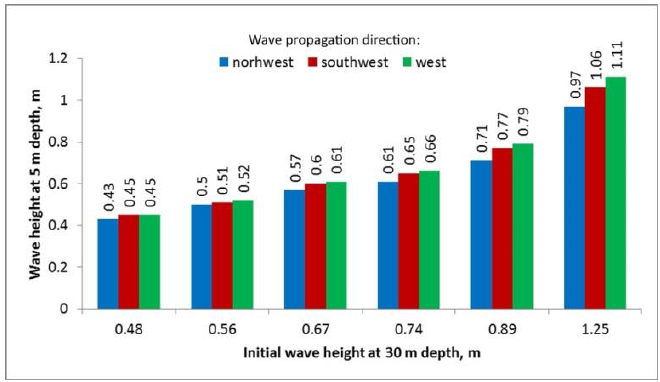
Figure 3. The change in height of waves propagating to the shore.